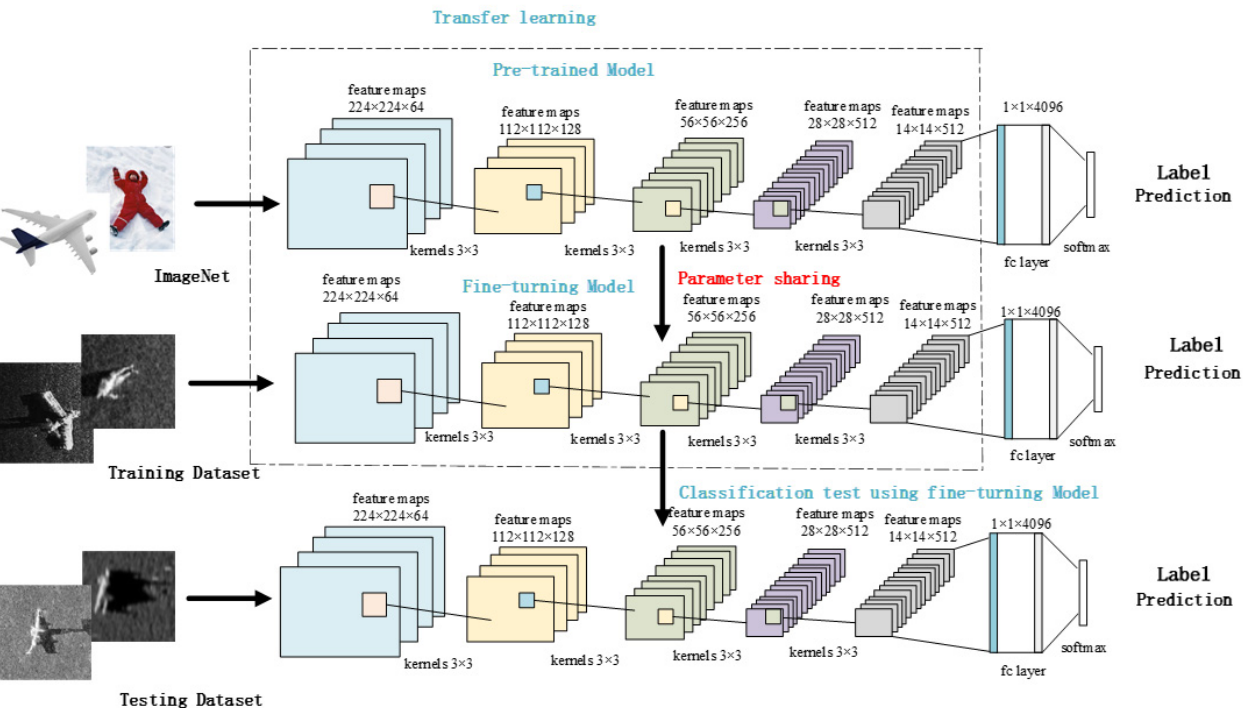
Figure 2. Deep transfer learning used in this paper. A CNN model is first pre-trained on the ImageNet dataset; then, the trained weights are transferred and the CNN model is fine-tuned by the side-scan sonar dataset; finally, the model is tested on the side-scan sonar image validation set.